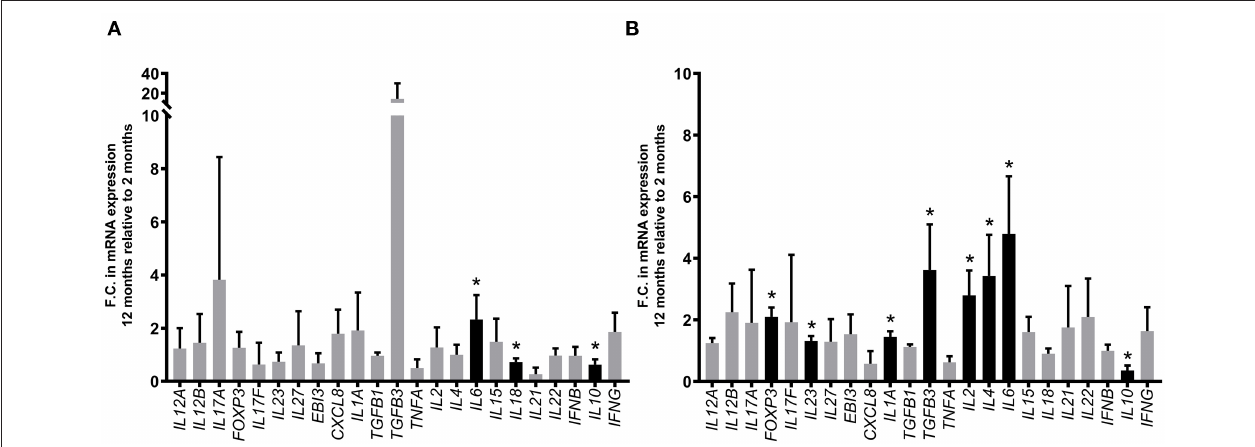
FIGURE 8 | Comparison of differentially expressed cytokine genes in DPP and CPP tissue from PBS control segments at 12 months relative to 2 months post-surgical isolation. Transcript abundance for 23 cytokine genes (assessed using the primers described in Supplementary Table 1 ) was quantified by qRT-PCR and normalized to the constitutively expressed gene YWHAZ . Bars represent the mean fold change (F.C.) at 12 months post-surgery (i.e., 12-month-old calves) relative to 2 months post-surgery (i.e., 2-month-old calves) in (A) DPP tissue ( n = 4 and n = 3, respectively) and (B) CPP tissue ( n = 4 and n = 3, respectively). * p < 0.05, black bars. Error bars represent standard